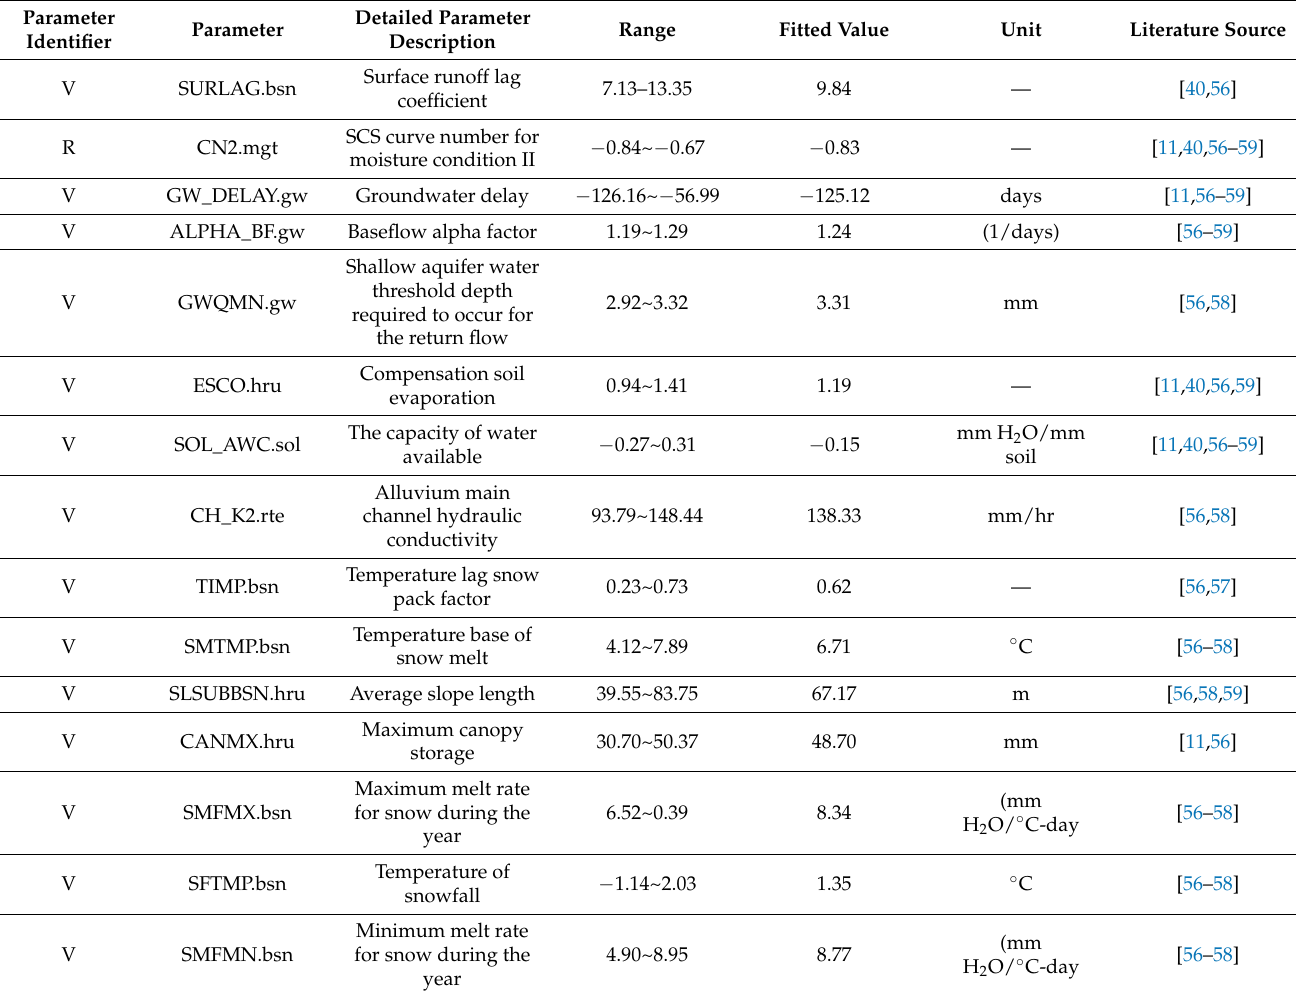
Table 1. Calibrated values of the parameters selected for SWAT calibration for Deckers Creek Watershed, Morgantown, West Virginia, USA. Note(s): “V”: The default parameter is replaced by a given value; “R”: The existing parameter value is changed relatively. “~” =